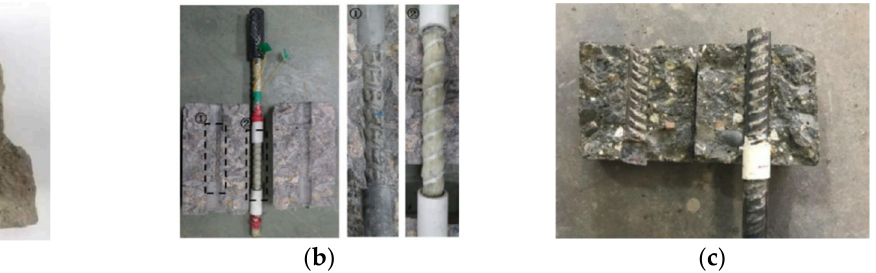
Figure 5. Failure performances of ( a ) ECR [105], ( b ) SFCB [94], ( c ) SCR in the bond test [101].